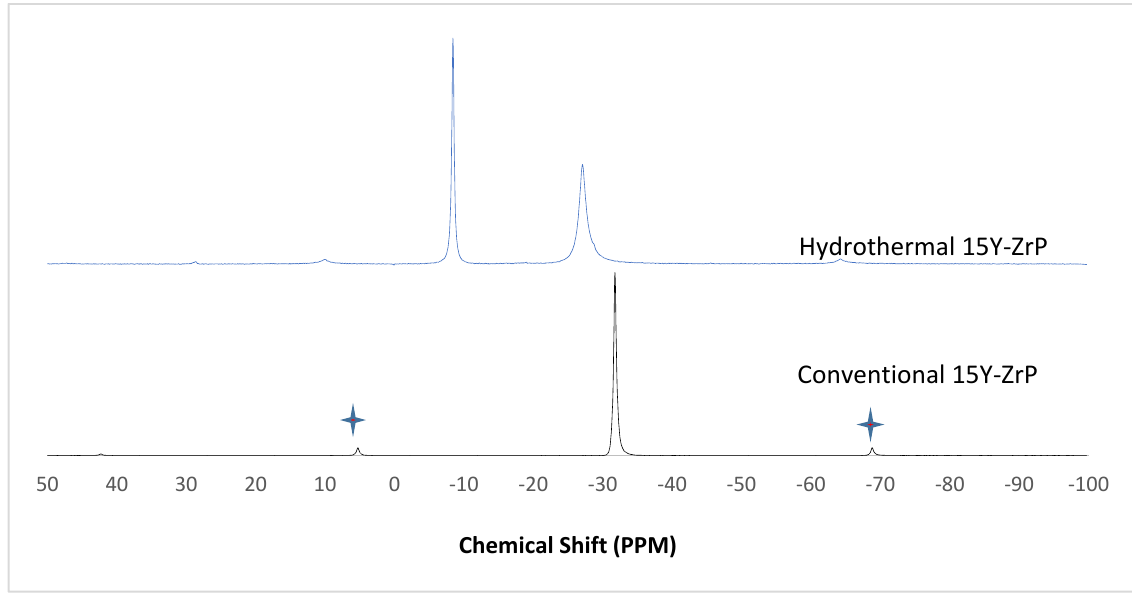
Figure 9. 31 P NMR of 15Y-ZrP synthesised using the two described methods (spinning side bands are shown as ).